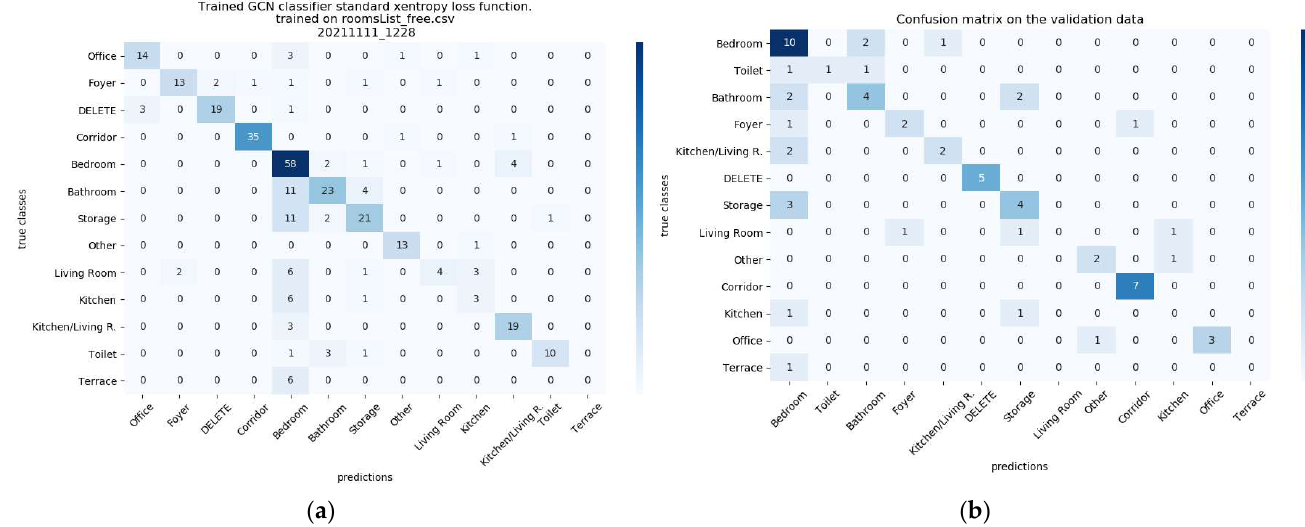
Figure 3. Confusion matrix for classification ( a ) of all the training and validation data, for which we obtained an accuracy of 72%. ( b ) For the validation nodes alone (which were 20% of the total nodes), we obtained an accuracy of 62%.